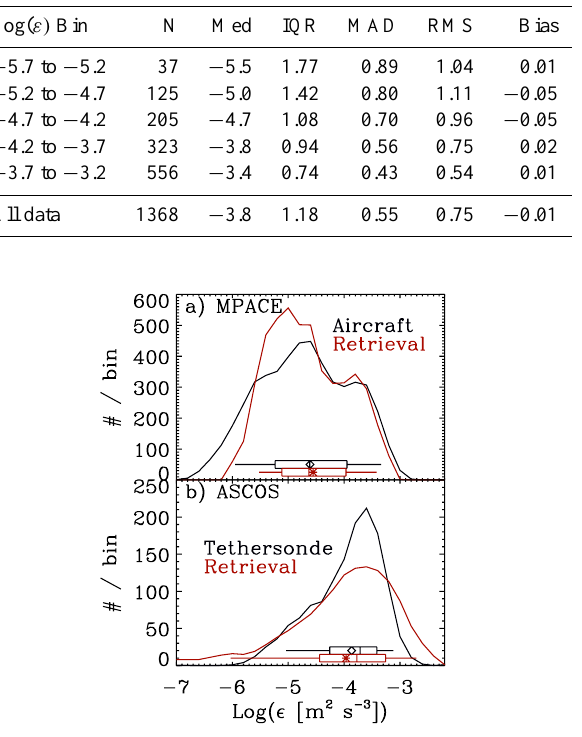
Fig. 7. Distributions of dissipation rate for all cases at (a) MPACE and (b) ASCOS. In each panel, box-and-whisker plots show the me- dian (middle bar), 25th and 75th percentiles (ends of box), 5th and 95th percentiles (whiskers), and mean as a